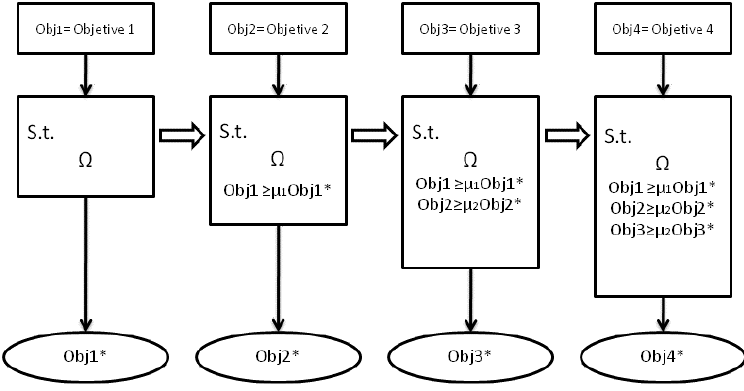
Figure 1. Visualization of the schema resolution